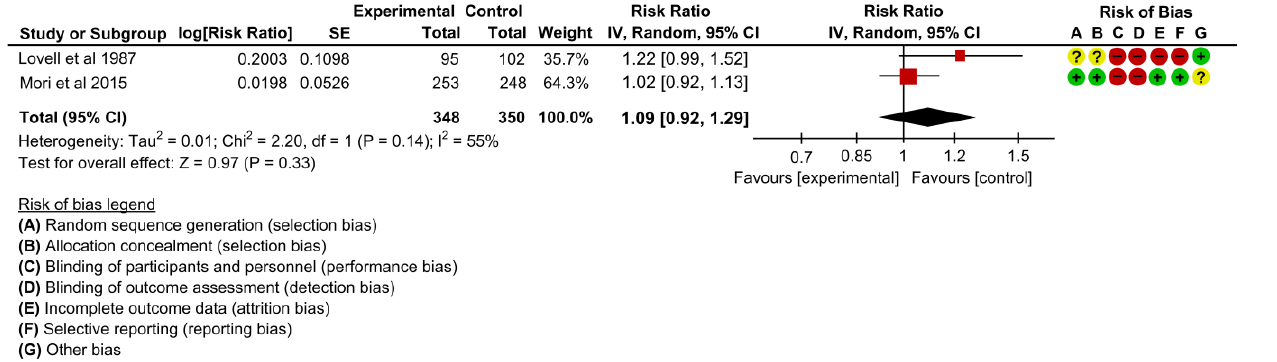
Figure 12. Meta-analysis for the effect of MCH handbook interventions vs. standard care on women satisfied with antenatal or maternity care [19,22]. Red color with a − symbol means a high risk of bias, yellow color with a ? symbol means an unclear risk of bias, and green color with a + symbol means a low risk of bias.